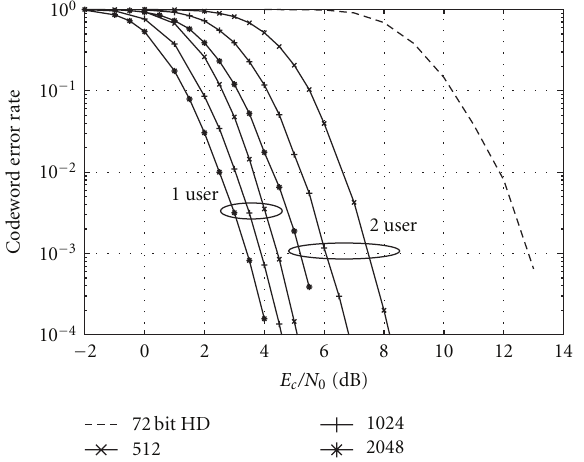
Figure 4: Codeword error rate performance results for codeword lengths of 512, 1024, and 2048 for 1 and 2 users on the AWGN channel. Results for the single user case when 72 hard decisions on the processed sequential pairs of channel samples are made and then used to solve for the spreading generator state are shown for comparison.